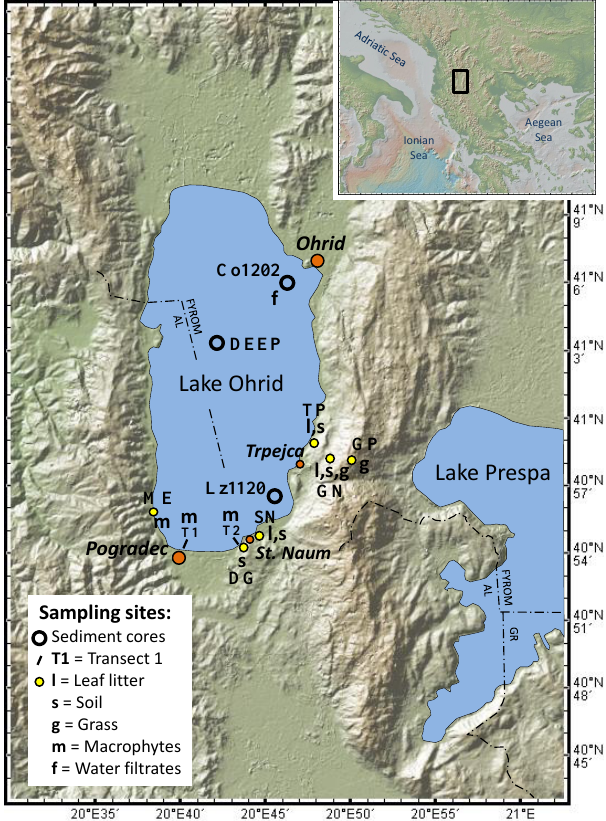
Figure 1. Locations of sediment core Lz1120 and sampling sites for modern materials in the Ohrid Basin. Lake Prespa contributes 28% of the inflow of meteoric water through karst systems. Inset: loca- tion of Lake Ohrid in the Balkans region of southeastern